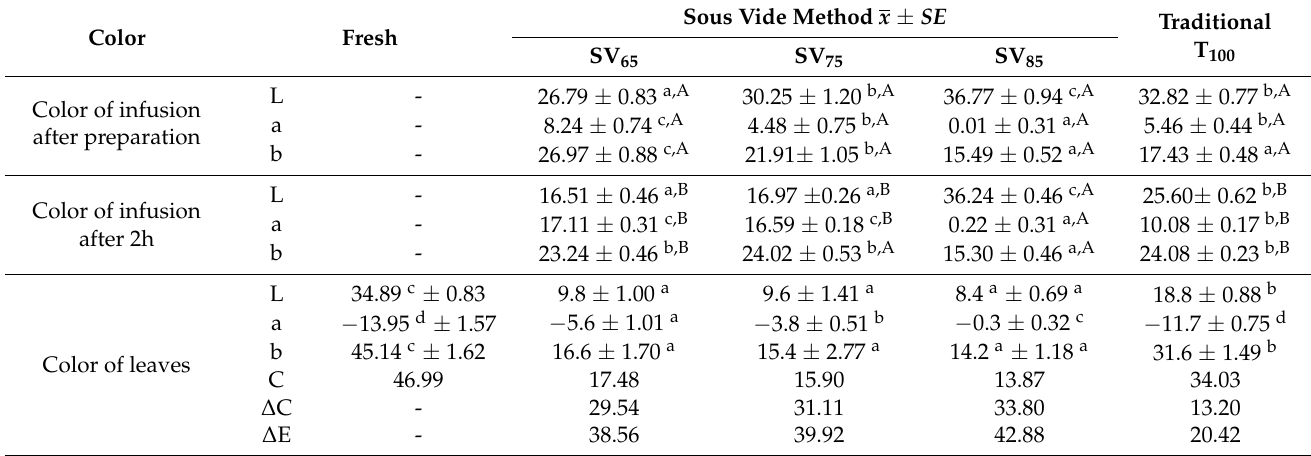
Table 3. The color of basil leaves and infusions measured